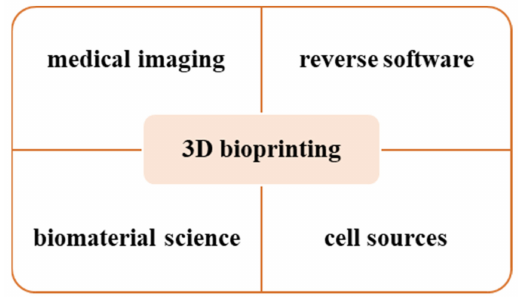
Figure 5. Elements essential for